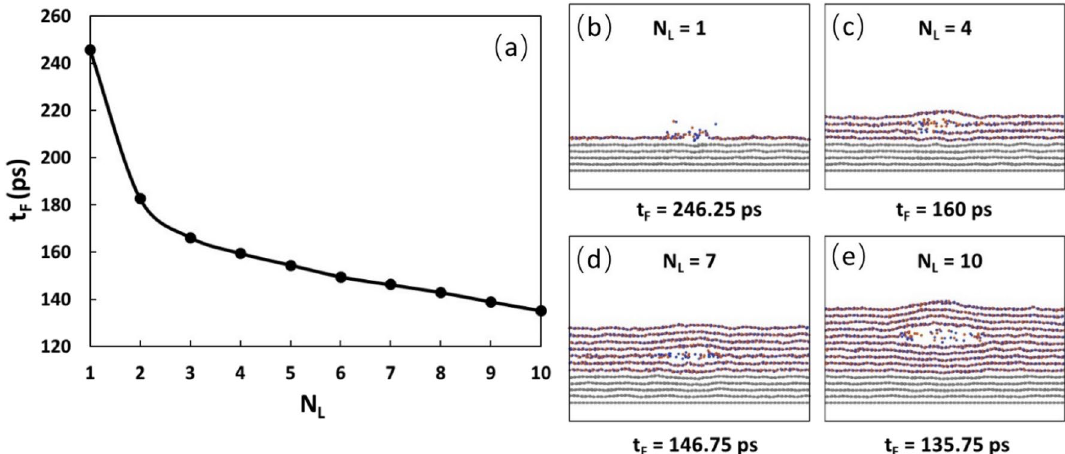
Figure 2. ( a ) Variation of failure start time with the number of h-BN layers. ( b – e ) Failure location for N L = 1, 4, 7, 10, respectively. For the failure start time, the general trend is that the thinner the film, the longer the failure start time. For the failure location, the general trend is that for thin h-BN films (N L = 1, 2, 3), the failure starts at the top layer. For thick thickness (N L > 4), the failure starts in one of the middle